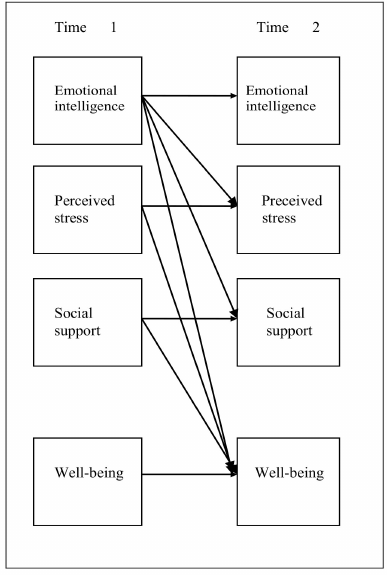
Figure 1. A theoretical model for